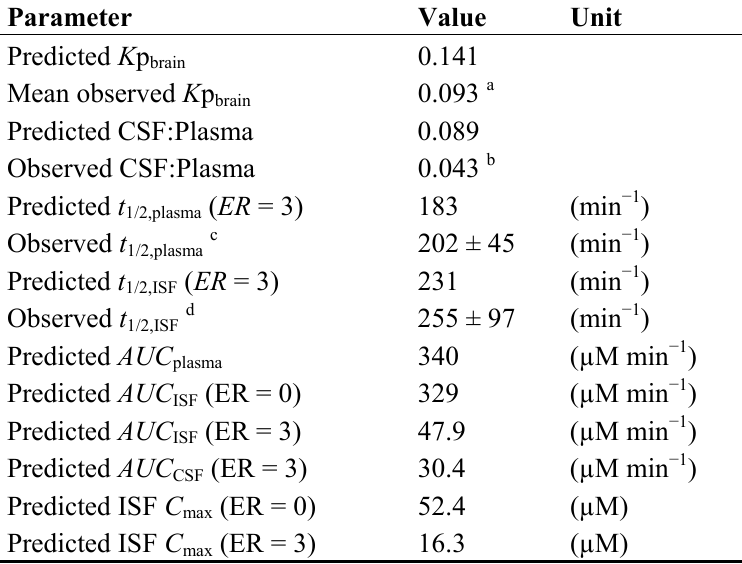
Table 2. Prediction of norfloxacin plasma, brain and CSF